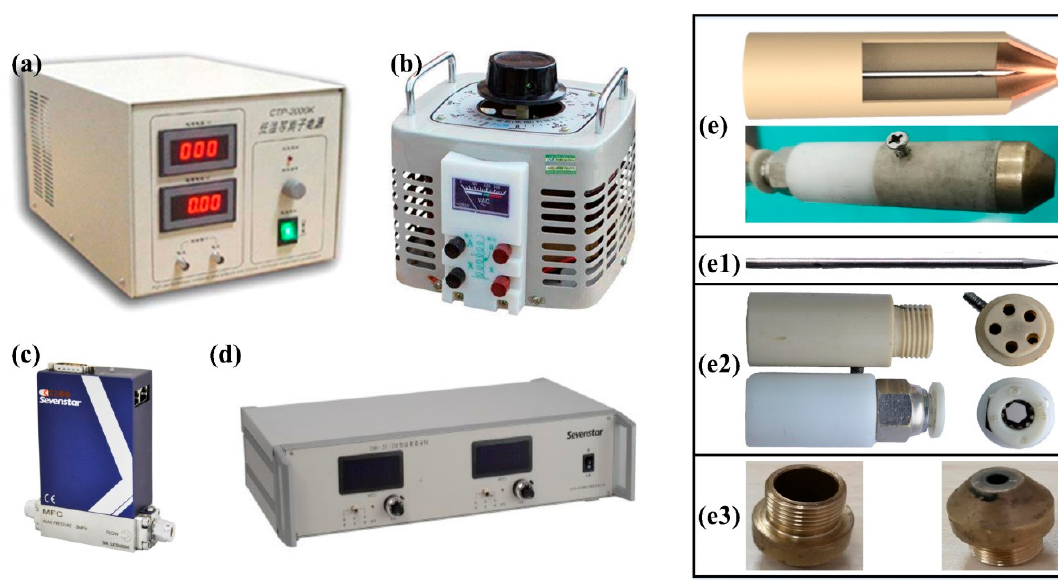
Figure 1. Components of atmospheric pressure cold plasma generating system: ( a ) alternating current (AC) power of low frequency, ( b ) voltage regulator, ( c ) gas mass flow controller, ( d ) gas flow meter,